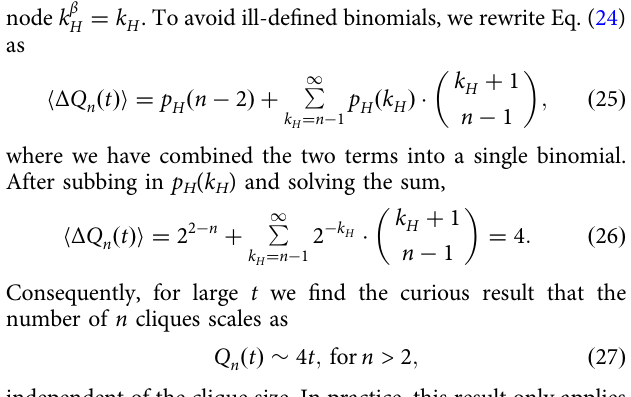
where we have used the property that p O ( k O < 2) = 0. Recalling